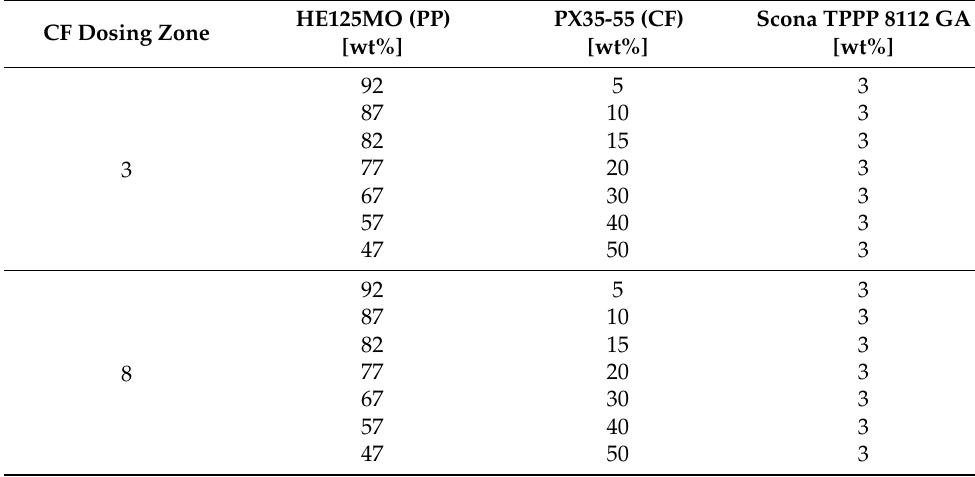
Table 1. Composite formulations produced in this study.